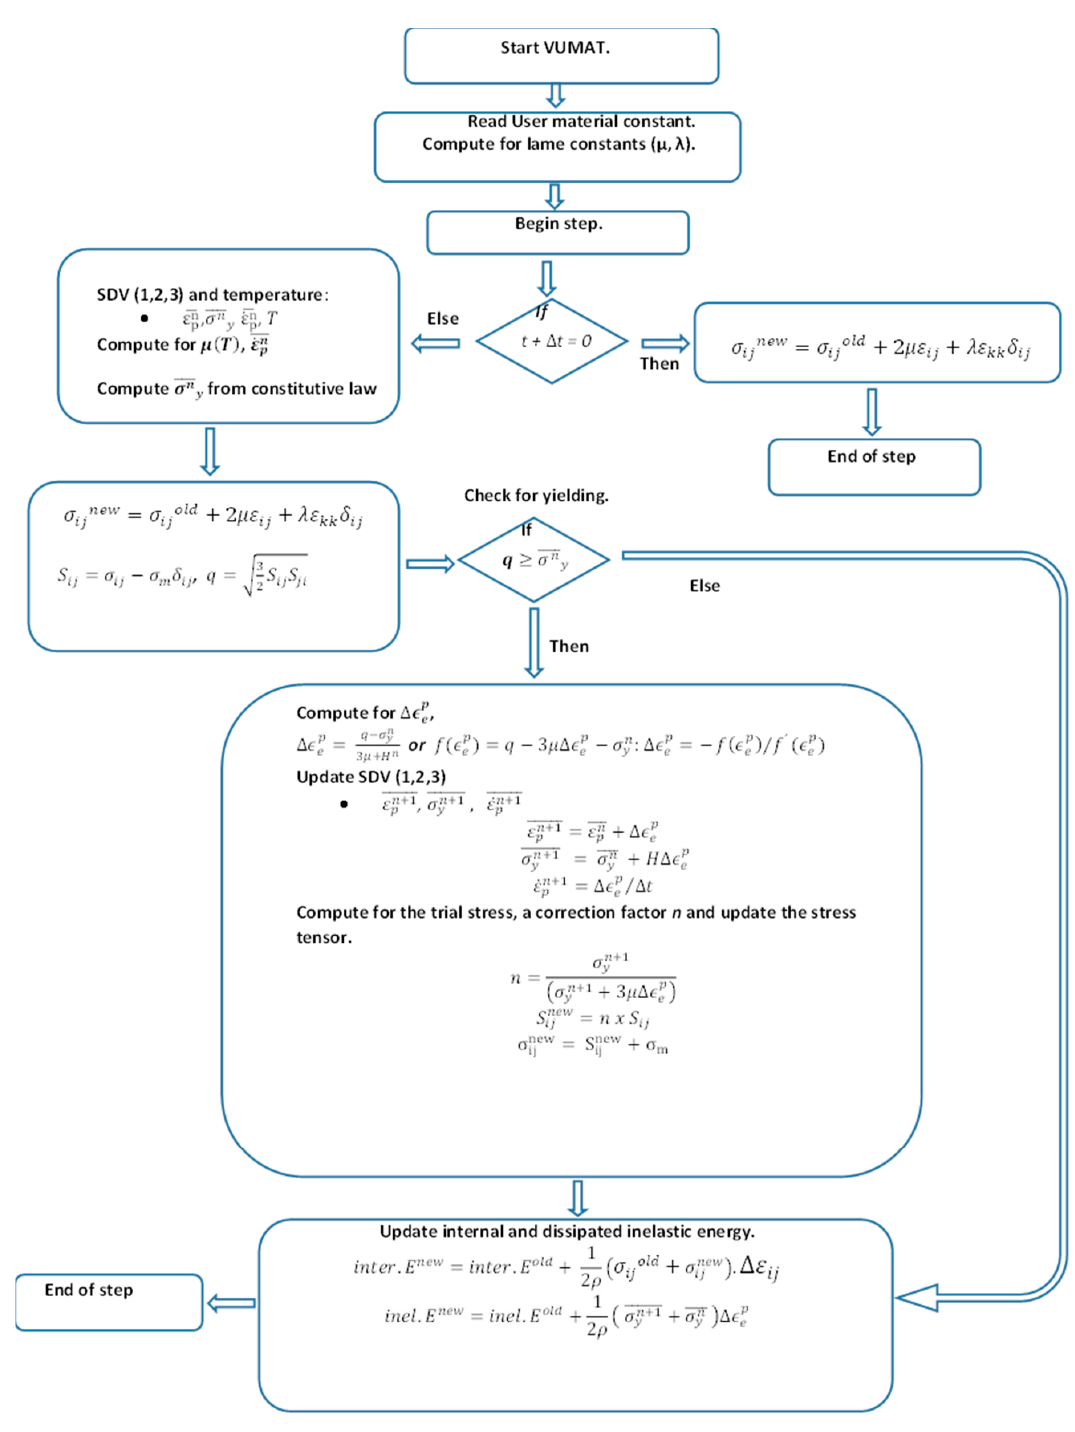
Figure 2. Algorithm developed in the present work to solve for equivalent plastic strain increments and updating of the related stress tensors. and updating of the related stress